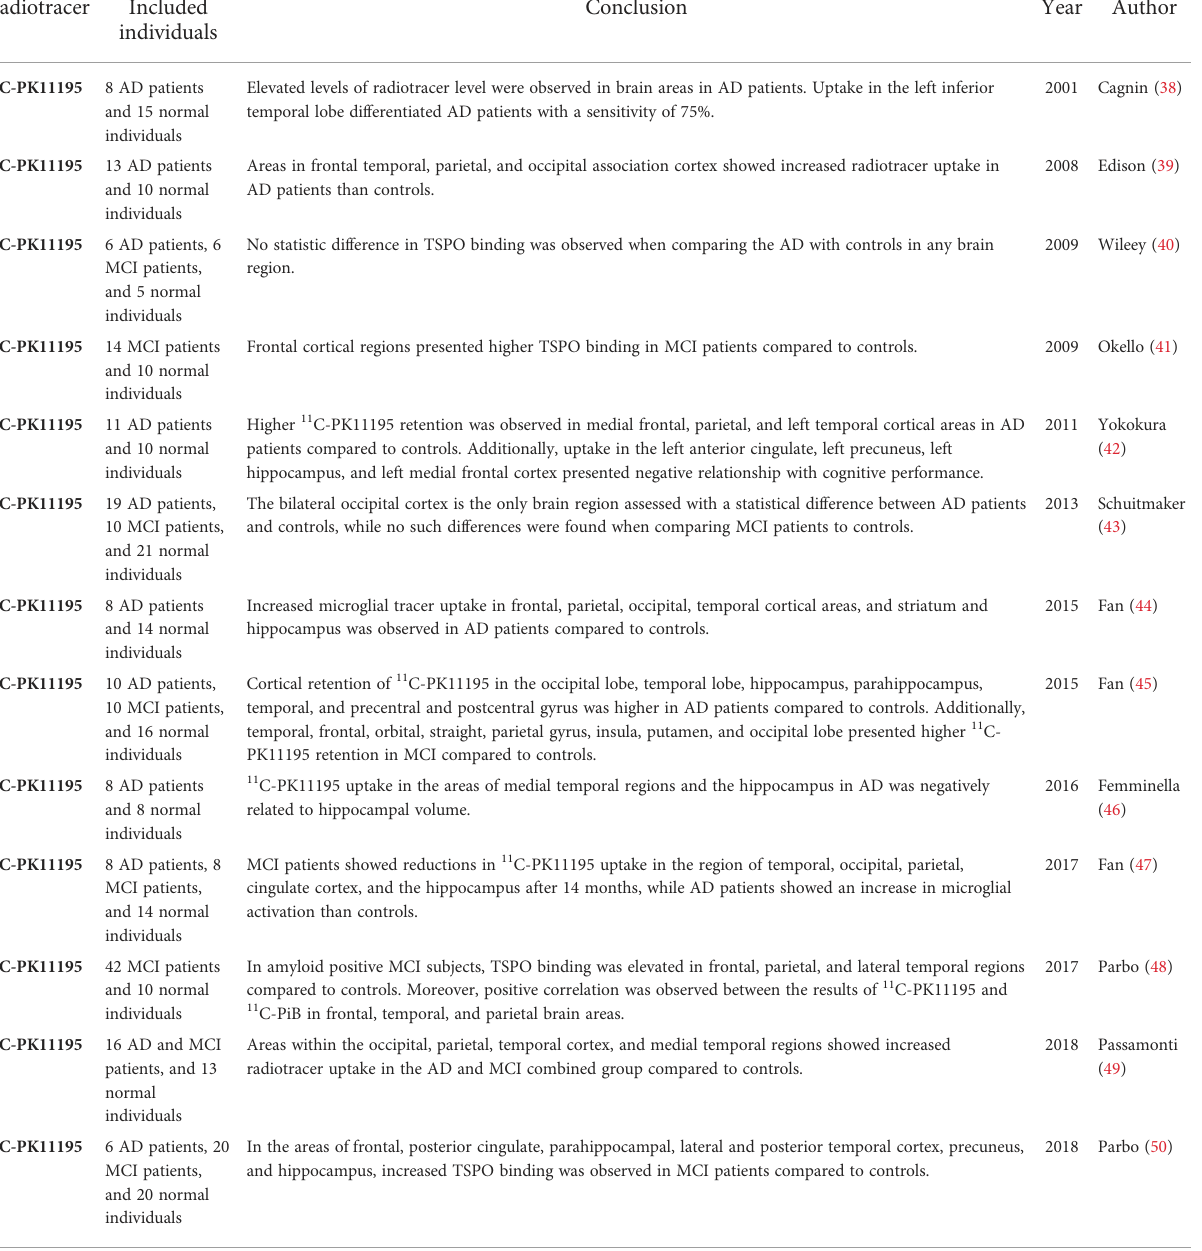
TABLE 1 Studies examining regional brain uptake via fi rst-generation TSPO tracers in AD and MCI. Radiotracer Included